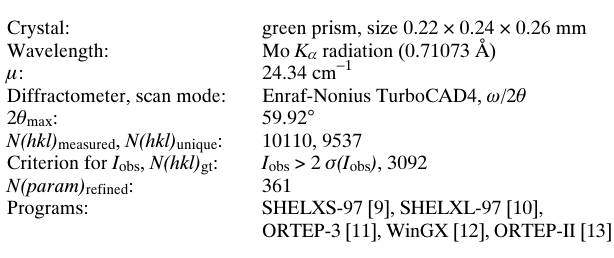
Table 1. Datacollection and